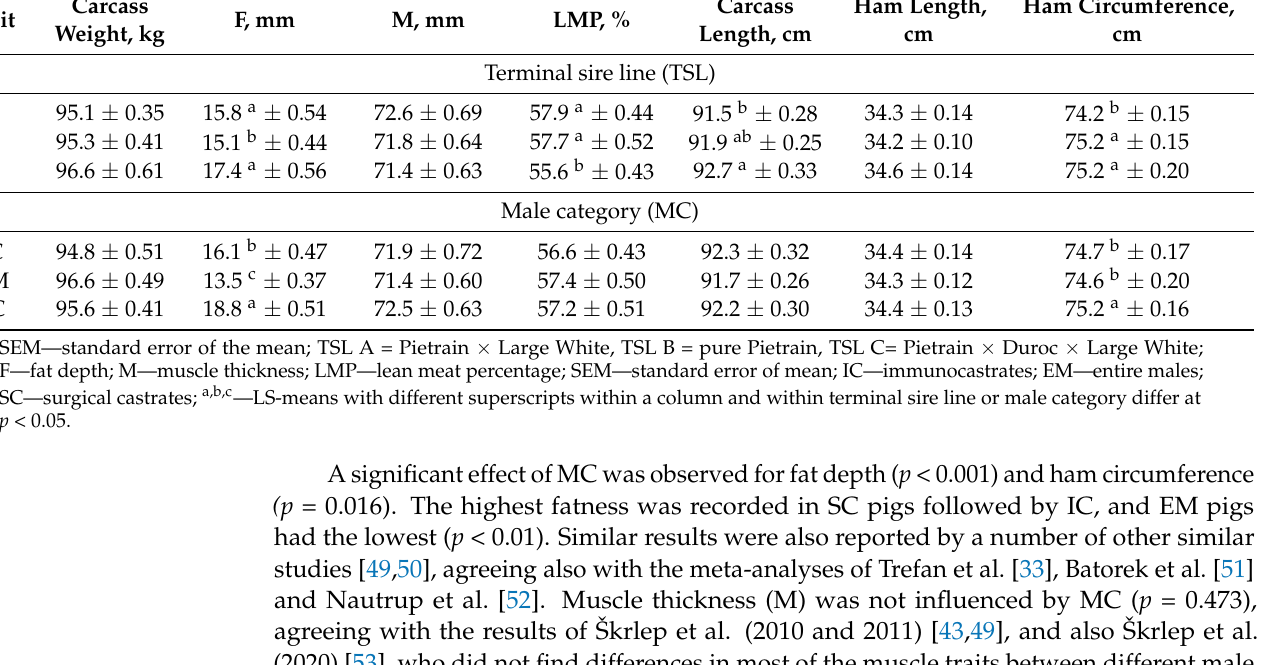
Table 1. Effect of terminal sire line and male category (LS mean ± SEM) on carcass traits.